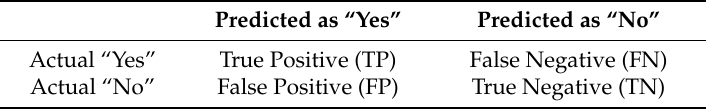
Table 6. Different outcomes of two-class prediction.